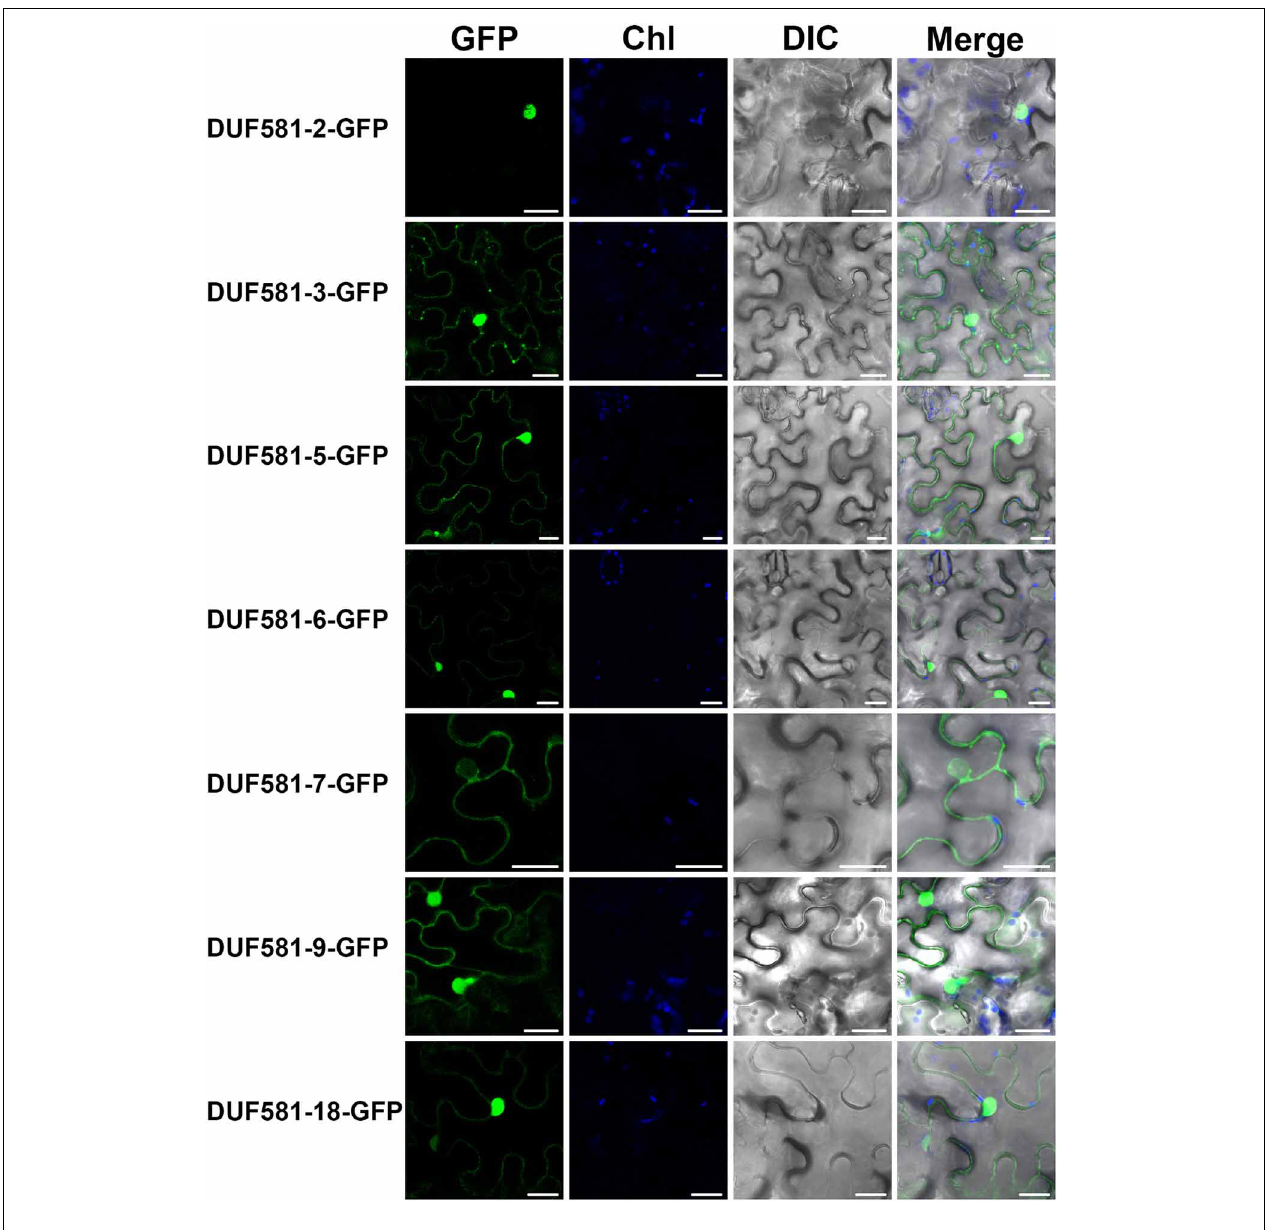
FIGURE 5 | Subcellular localization of DUF581-GFP proteins. Subcellular localization of DUF581-GFP tagged proteins in N. benthamiana leaves transiently transformed by Agroinfiltration. The